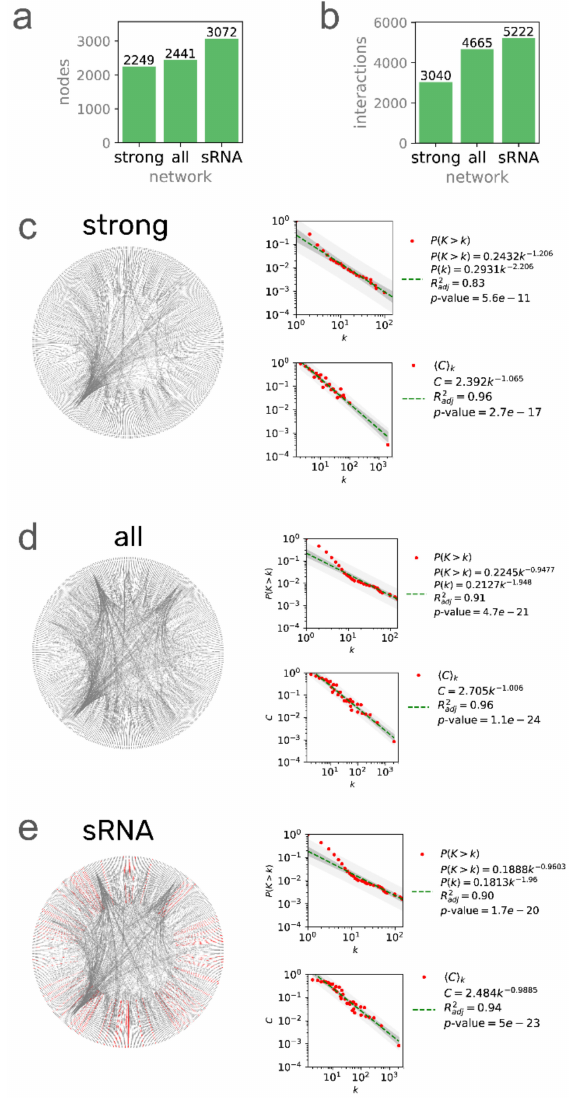
Figure 1. Three network models of the C. glutamicum regulatory network. The number of nodes ( a ) and in- teractions( b )forthethreenetworks. Network, P(k), andC(k)distributionsfor( c )196627_v2020_s21_eStrong ( strong ), ( d ) 196627_v2020_s21 ( all evidence ), and ( e ) 196627_v2020_s21_dsRNA ( sRNA ) networks. Network plots were generated with Circos [36] using the leftmost gene/sRNA coordinates to sort the nodes clockwise. Nodes with no coordinates in the genome annotation were